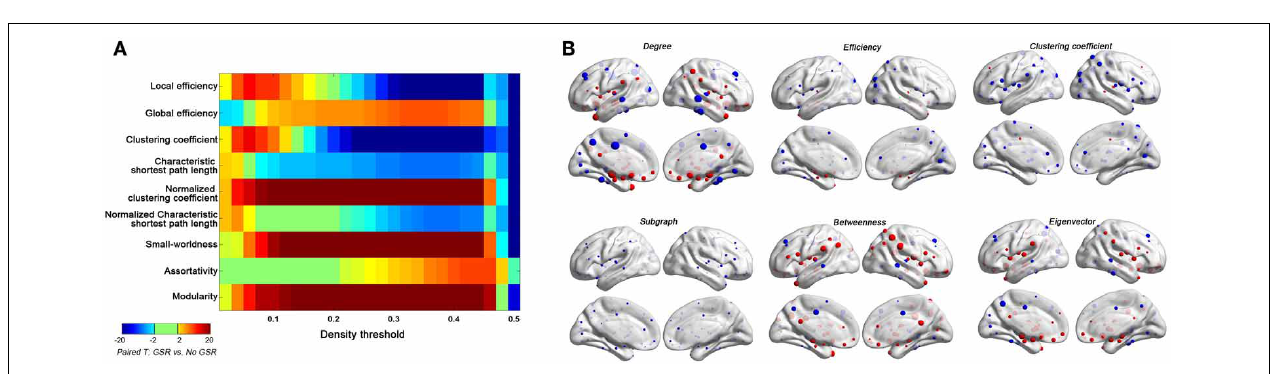
FIGURE 10 | Impact of GSR on global topological properties (A) and regional topological properties (B) based on Friston-24 model. In panel (B) , the regional properties were characterized by the area under the curve (AUC) of each measure integrated within density range of 0.06–0.44. The